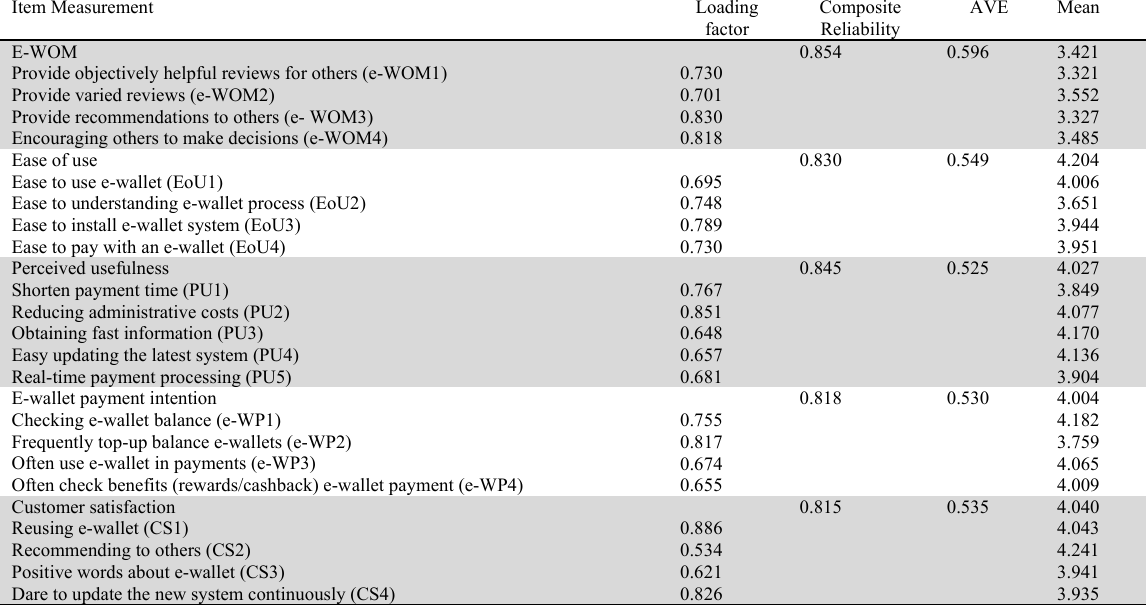
Validity and Reliability of the Constructs Item Measurement Loading